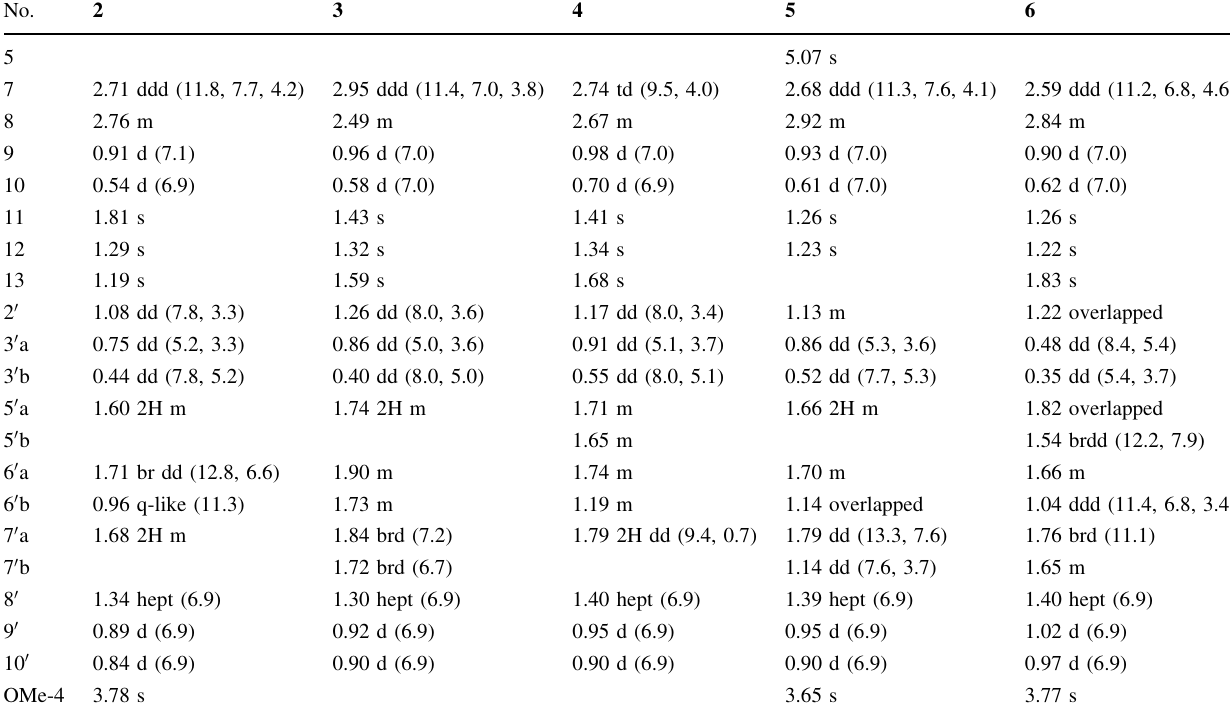
Table 2 1 H (500 MHz) NMR data of 2 – 6 in CDCl 3